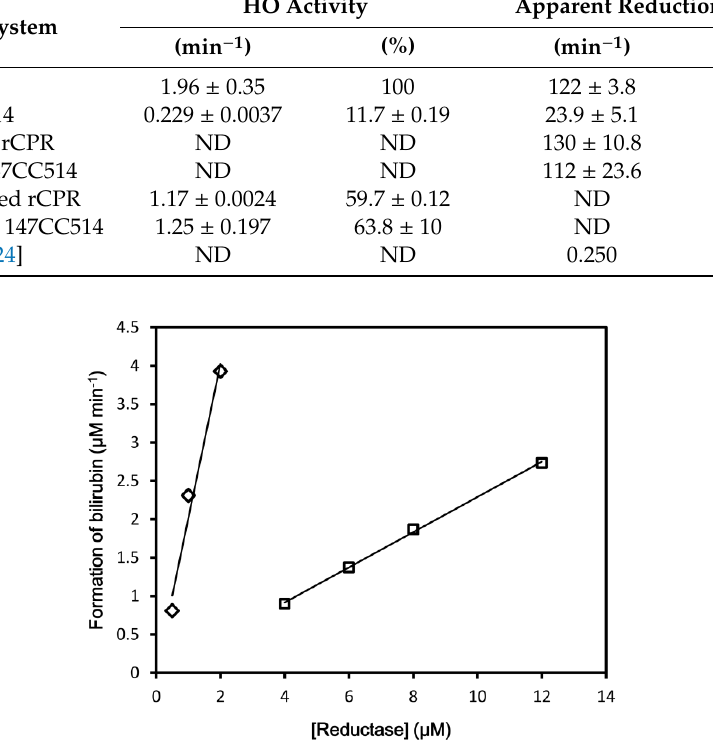
Figure 1. HO-1 activity. Bilirubin formation rates obtained in the NADPH–rCPR and NADPH–147CC514 systems were plotted as blank diamonds and squares, respectively. A representative example of the multiple measurements performed is displayed. See Methods for details.